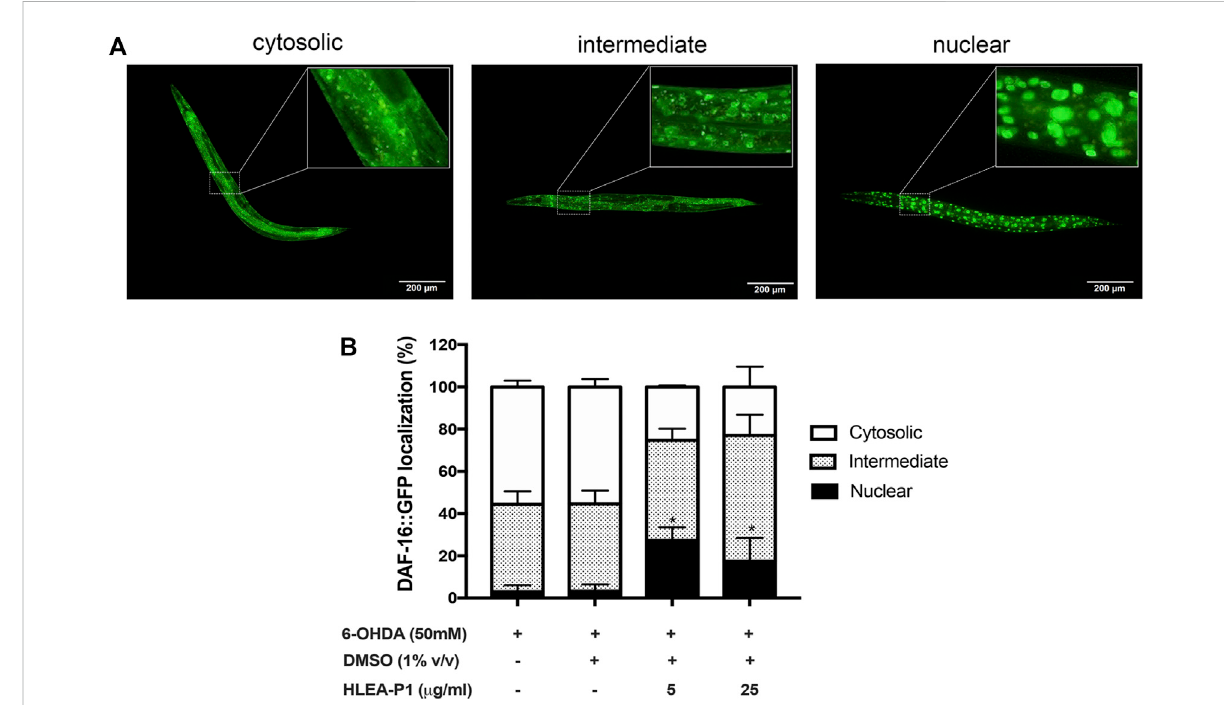
FIGURE 6 EffectofHLEA-P1onnuclearlocalizationoftranscriptionfactorDAF-16in6-OHDA-induced C.elegans. (A) Representative fl uorescentimages of different subcellular localization of DAF-16. (B) Graphical representation of subcellular distribution of daf-16 . The data are presented as mean ± SEM (with three independent replicates, n ≥ 30 number of animals per replicate). The asterisk (*) indicated signi fi cant differences of DAF-16 nuclear localization between untreated group (6-OHDA/DMSO) and HLEA-P1-treated groups at p <